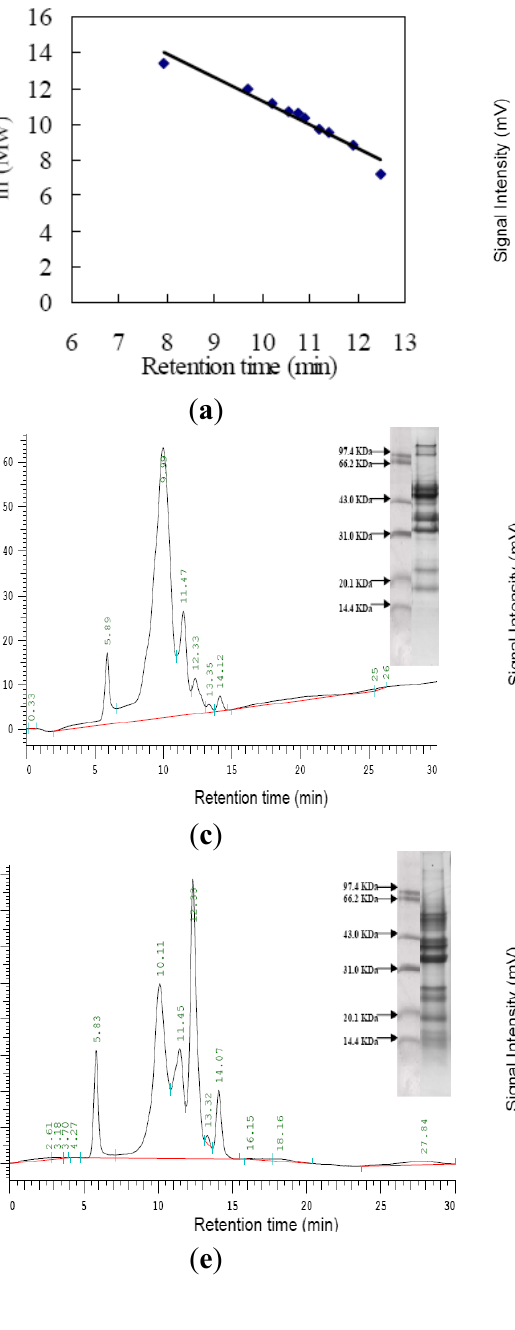
Figure 4. Molecular weight distribution of defatted walnut flour and walnut proteins fractions. ( a ) The calibration curve of standard proteins; ( b ) Defatted walnut flour; ( c ) Globulin; ( d ) Glutelin; ( e ) Albumin; ( f ) Prolamin. Figure inside was SDS-PAGE without β -mercaptoethanol. A calibration curve of 10 standard proteins was used for interpreting the results. Ten standard proteins were thyroglobulin ( M : 669, 000), aldolase ( M : 158,000), W W BSA ( M : 67,000), ovalbumin ( M : 43,000), peroxidase ( M : 40,200), adenylate W W W kinase ( M : 32,000), myoglobin ( M : 17,000), ribonuclease A ( M : 13,700), aprotinin W W W : 6500), and vitamin B12 ( M : 1350), ( M W W